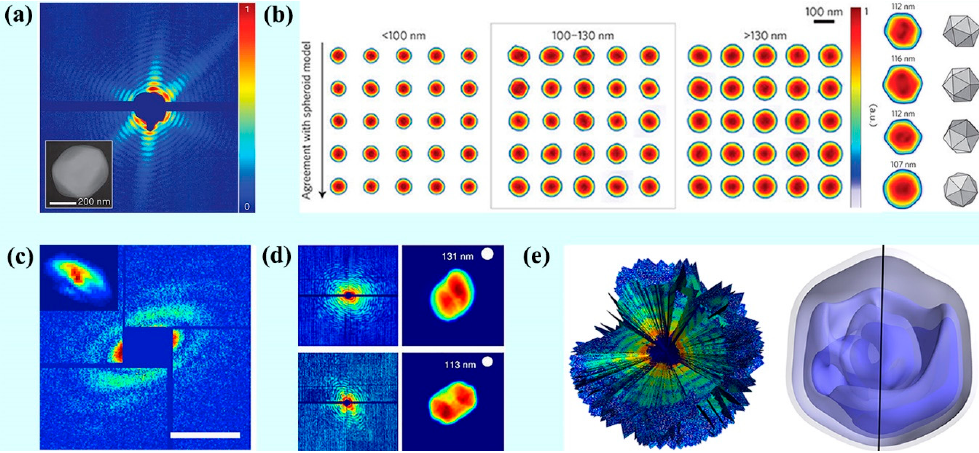
Figure 3. Coherent diffractive imaging of biological samples with X-ray free-electron lasers. ( a ) First coherent diffraction imaging of biological samples with hard X-ray lasers at LCLS. The sample, mimivirus, is one of the largest known viruses. The total diameter of the particle, including fibrils, is about 750 nm. The full-period resolution of this first demonstration is ~32 nm; ( b ) High-throughput imaging of heterogeneous cell organelles. Around 70,000 low-noise diffraction patterns were collected within 12 min at LCLS at a frequency of 120 Hz. Real space images with different organelles’ size and shape were phased automatically; ( c ) Structure determination of RNAi microsponge combining single-shot X-ray free-electron laser (XFEL) diffraction with synchrotron-based coherent diffraction imaging; ( d ) Living cell imaging of cyanobacteria with XFEL. Living cyanobacteria were injected to the X-ray laser using an aerosol particle injector; ( e ) The first demonstration of three-dimensional imaging of biological samples. Mimivirus was delivered to the X-ray laser beam, hundreds of random orientation diffraction patterns were collected. After hit finding, single-shot classification and orientation determination, a three-dimensional diffraction volume was obtained. The spatial resolution was estimated to ~125 nm. (Figure 3a was reproduced with permission from [135]. Copyright Springer Nature, 2011. Figure 3b was reproduced with permission from [137]. Copyright Springer Nature, 2014. Figure 3c was reproduced with permission from [136]. Copyright Springer Nature, 2014. Figure 3d was reproduced with permission from [141]. Copyright Springer Nature, 2015. Figure 3e was reproduced with permission from [139]. Copyright American Physical Society, 2015).